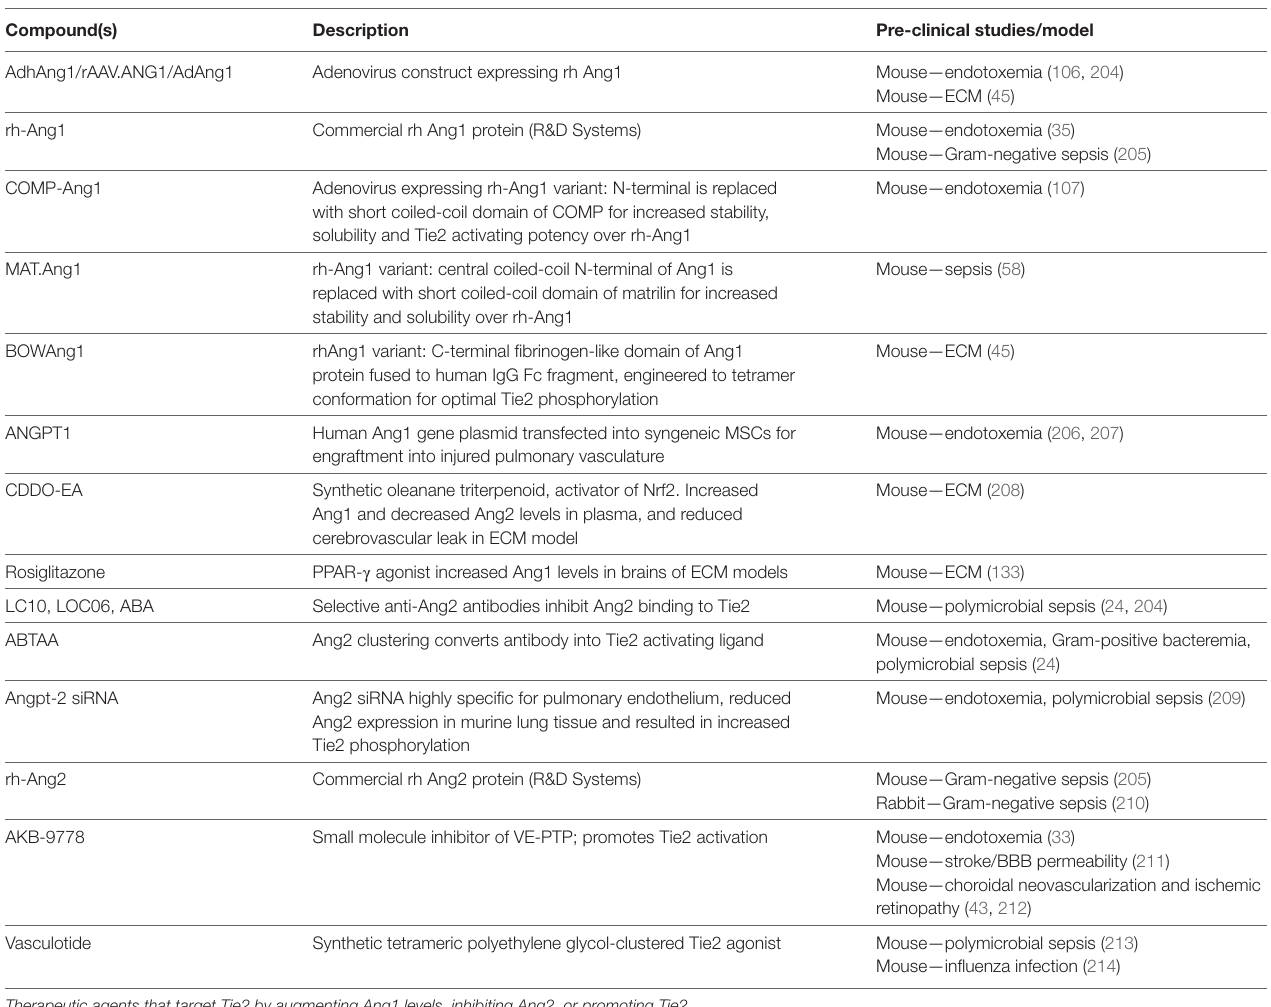
TABLe 1 | Ang/Tie2-targeted therapies in pre-clinical studies of sepsis.